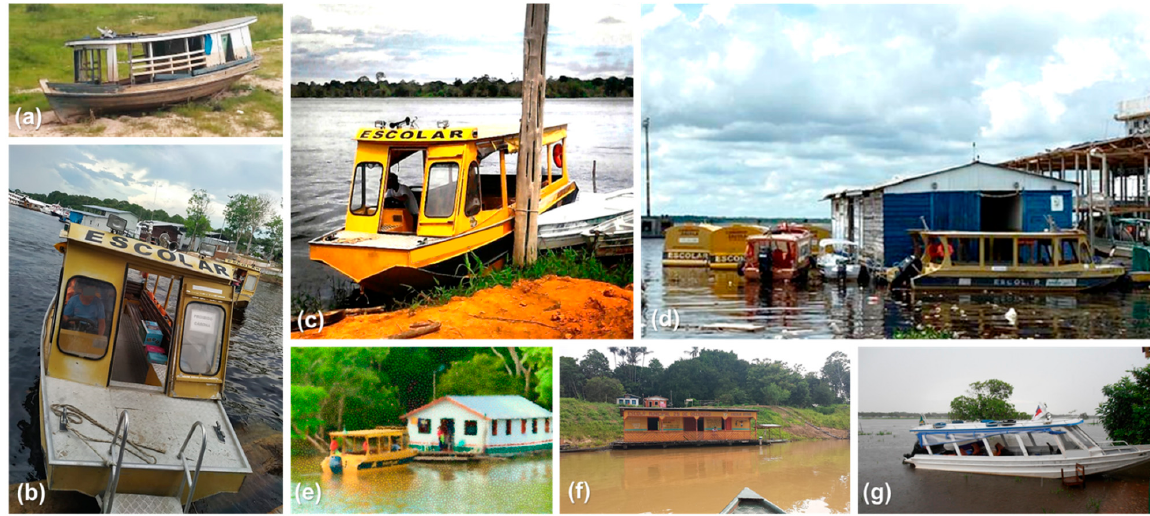
Figure 5. School transport in the state of Amazonas, Brazil. ( a ) An old boat used to transport children to school about ten years ago (Kleyphide Pereira da Silva 2020). ( b ) Front view of an Amazon school boat promoted by the government in